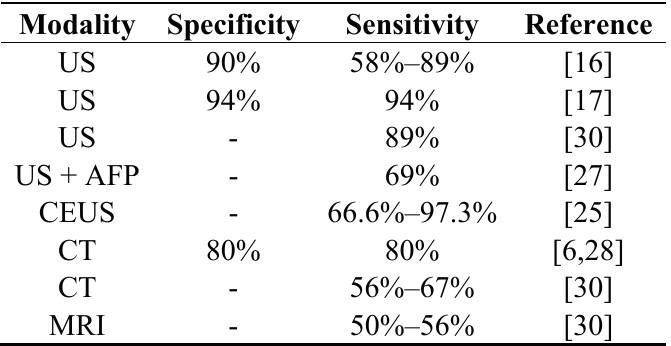
Table 1. Comparison of HCC Imaging